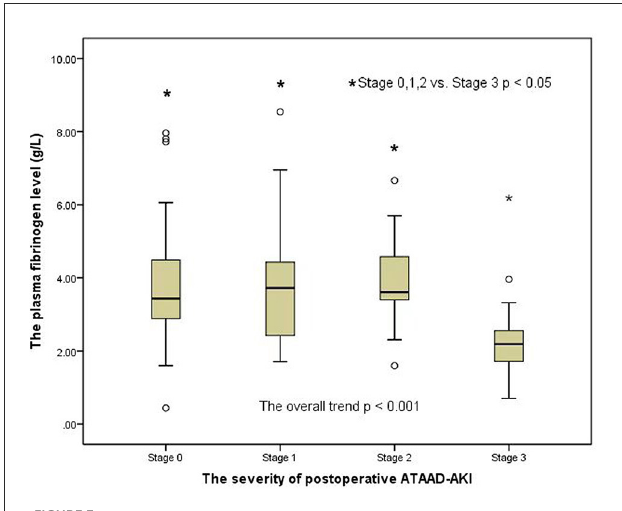
FIGURE3 Changes in preoperative fibrinogen level among the AKI groups.